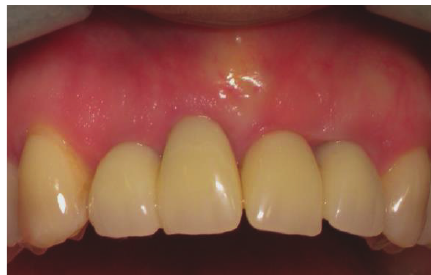
Figure 19: Front view of restoration at five-year